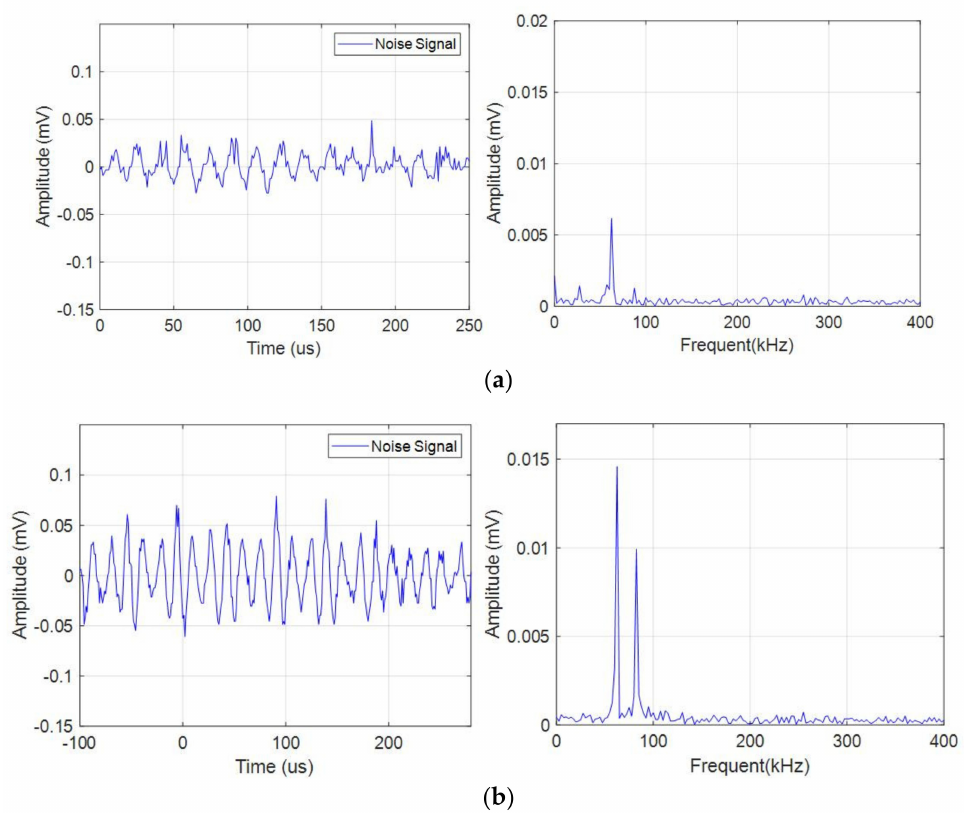
Figure 4. Time domain-frequency domain diagram of continuous acoustic emission signal. ( a ) Charge process; ( b ) Dis- charge process.